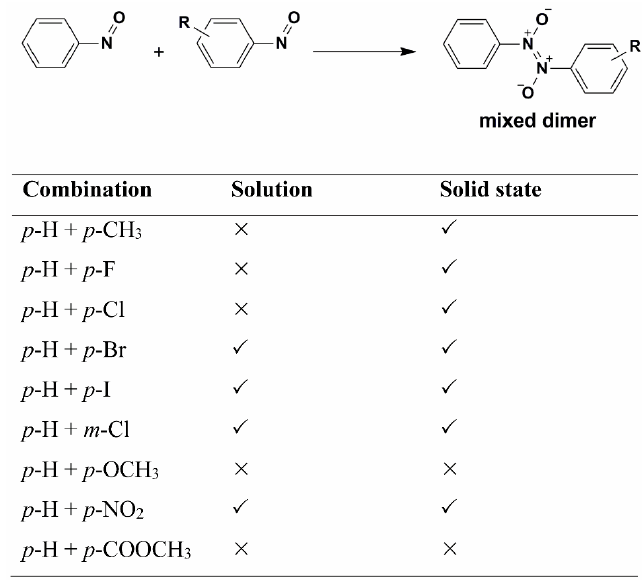
Scheme 2. Cross-dimerization of nitrosobenzene derivatives in solution and in solid state.